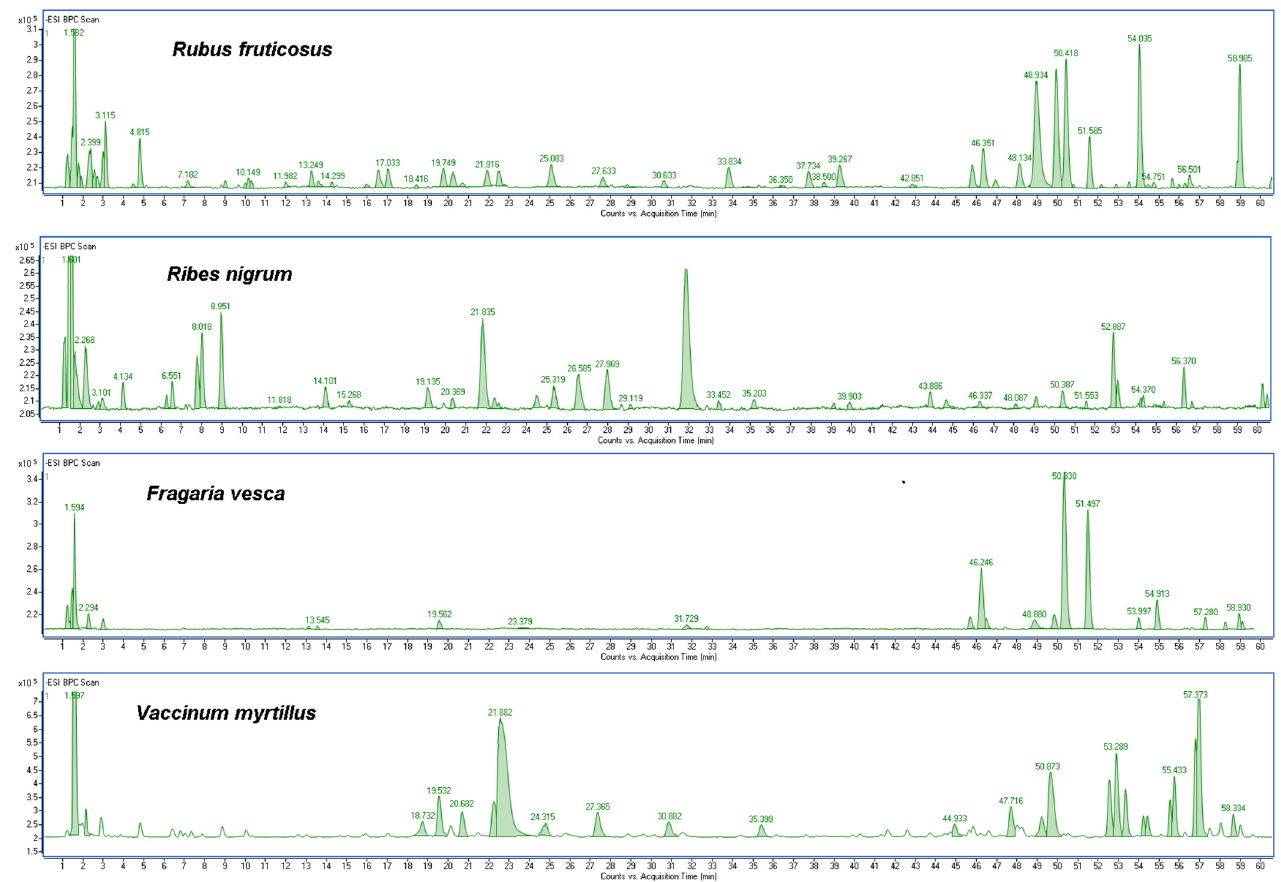
Figure 1. Representative BIC chromatograms for R. fruticosus L., R. nigrum L., F. vesca L., V. myrtillus L. Table 2. UHPLC/DAD/ESI ‐ MS quantitative analysis of R. fruticosus L., R. nigrum L., F. vesca L., V. myrtillus L. water extracts and kombucha ferments. Values are means ± standard deviation (SD) of triplicate.